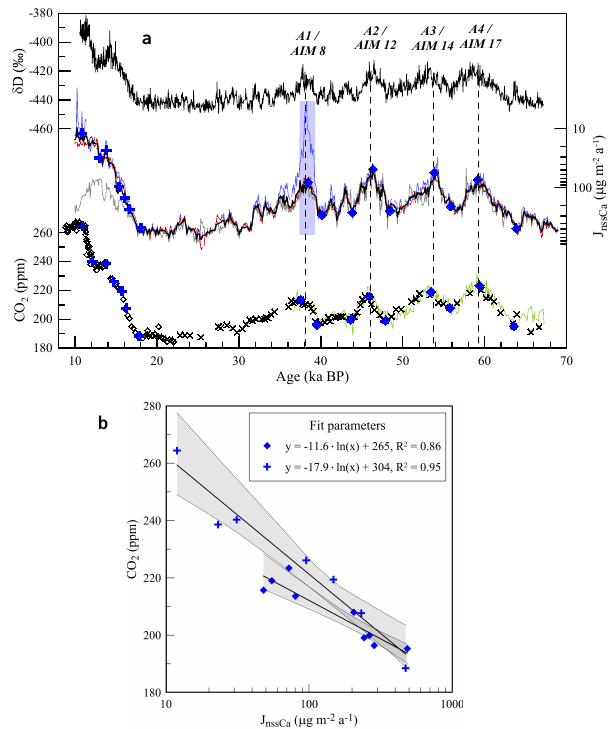
Fig. 5. (a) Estimate of CO 2 sensitivity on dust changes. EDC δ D is shown in the top panel, CO 2 concentrations from EDC (black open diamonds) and Taylor Dome (black crosses) in the bottom panel. More recent EDML and TALDICE CO 2 concentrations (Bereiter et al., 2012) are shown for comparison (green line). The middle panel shows the mean nssCa 2 + flux ( J nssCa ) calculated from the 100yr medians of EDC, EDML, and TALDICE (black line); dis- carded EDC values during AIM 8 are marked by the blue shaded area. Blue diamonds and crosses in the bottom panel indicate the same tie points used for the linear regression calculation as done by Röthlisberger et al. (2004). In addition, the 100yr means of EDC (blue line), offset-corrected EDML (red line), and TALDICE (grey line) are shown in the middle panel. (b) Linear regressions of the blue diamonds and crosses from (a) , according to Röthlisberger et al. (2004). Due to the discarded EDC values during AIM8 we obtain a regression line of the diamonds (representing CO 2 and nssCa 2 + during A4–A1) much closer to the one during T1, indi- cated by the crosses. Grey shaded areas indicate the 95% signifi- cance